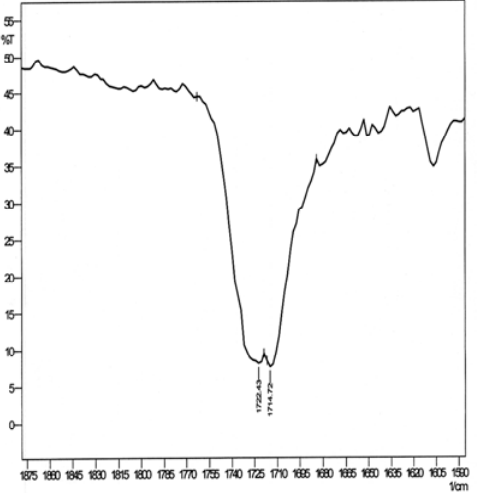
Figure 2. FT-IR spectrum of